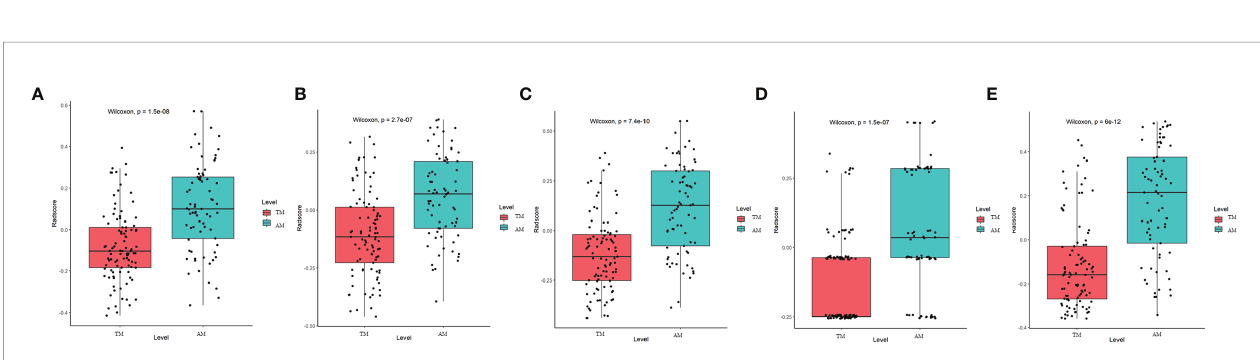
FIGURE 4 | Plots (A – E) show the boxplots of the corresponding radiomics score in the T1C, T2, combination of T1C and T2, clinical and clinicoradiomics models,